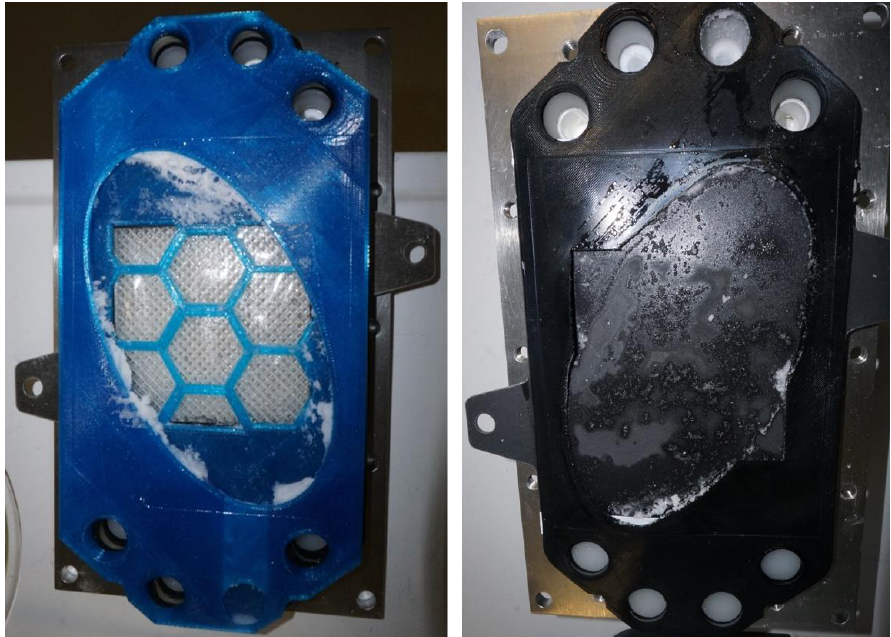
Figure 9. On the left, the prototype of the anode chamber and the membranes are shown after experimentation; on the right, the anode can be seen. No scaling on either the membrane or the anode was